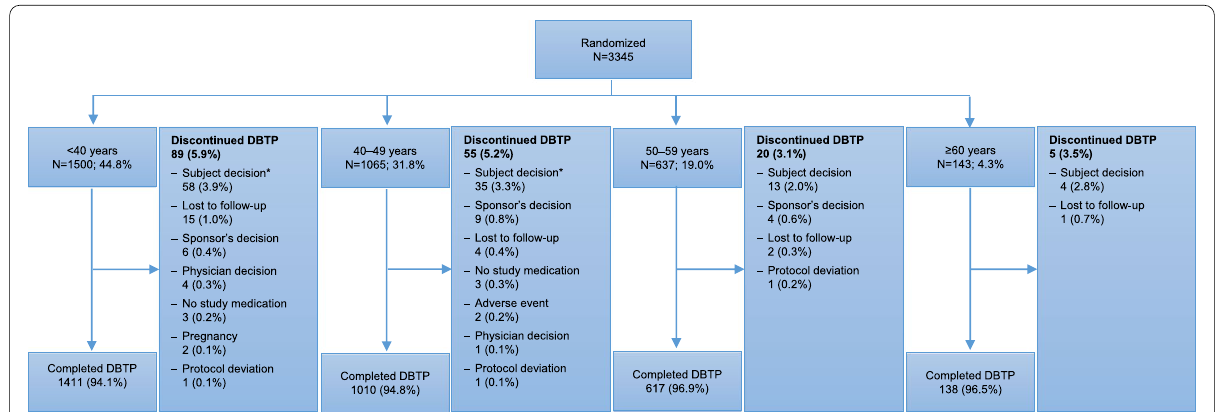
Fig. 2 Disposition of participants. *Subject decision was a sum of subject decision and subject/guardian decision. In the EMPOwER study, six randomized participants did not take the study medication and were not formally entered into the DBTP; these participants are counted under the “no study medication” category. Abbreviation: DBTP, double-blind treatment